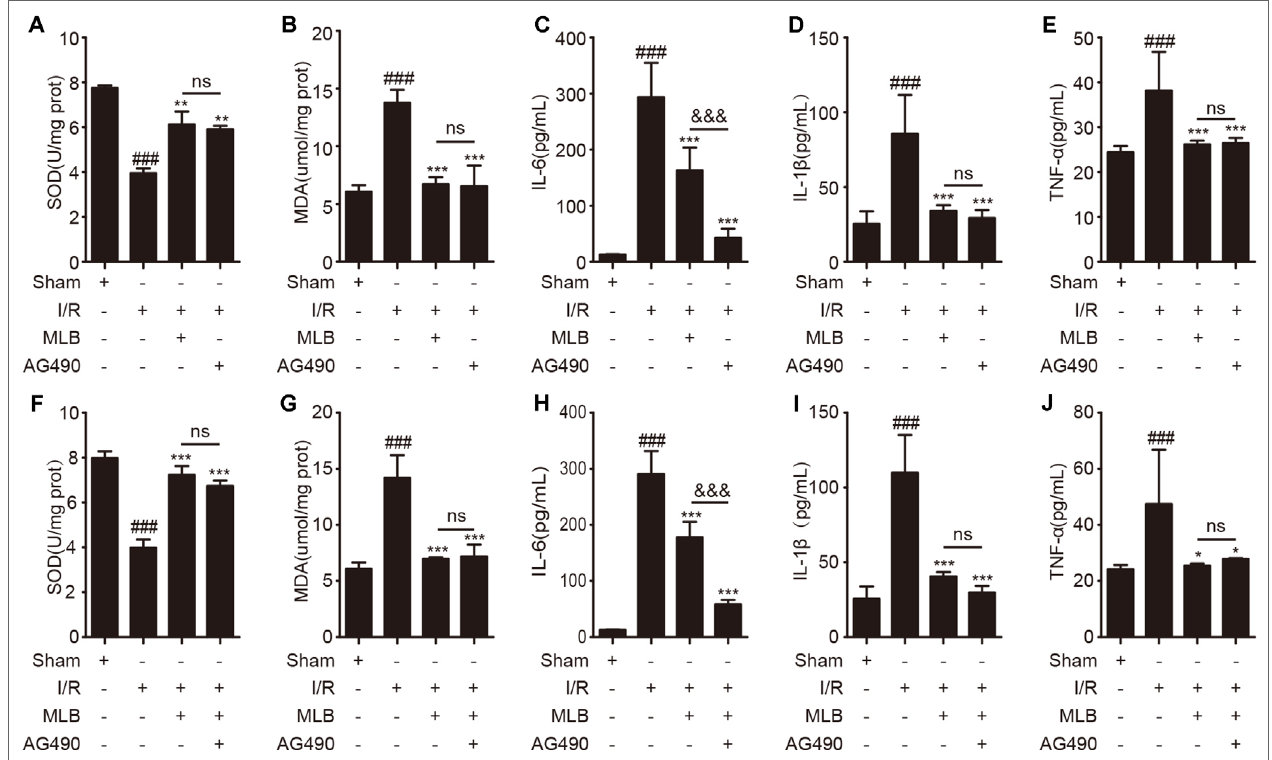
FIGURE 6 | AG490 or MLB+AG490 pretreatment affected oxidative stress in liver and inhibited inflammatory factors’ expression. (A , B) The expression of SOD and MDA in liver tissue of sham, I/R, MLB, and AG490 groups. (C – E) Serum IL-6, IL-1 β , and TNF- α were detected by ELISA in sham, I/R, MLB, and AG490 groups. (F – G) The expression of SOD and MDA in liver tissue of sham, I/R, MLB, and MLB+AG490 groups. (H – J) Serum IL-6, IL-1 β , and TNF- α were detected by ELISA in sham, I/R, MLB, and MLB+AG490 groups. The data are expressed as mean ± SD; n = 5 for each group; ns: no statistical significance; ### P < 0.001 versus sham group; *P < 0.05, **P < 0.01, and ***P < 0.001 versus I/R group; &&& P < 0.001 versus MLB